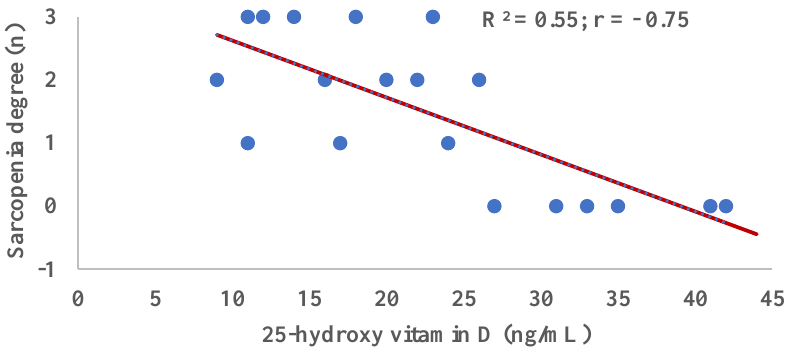
Figure 1. Correlation of Sarcopenia Degree and 25-hydroxy vitamin D (25-OH/D) concentration. Degrees of Sarcopenia: 0, absence; 1, Probable; 2, Confirmed; 3, Severe.